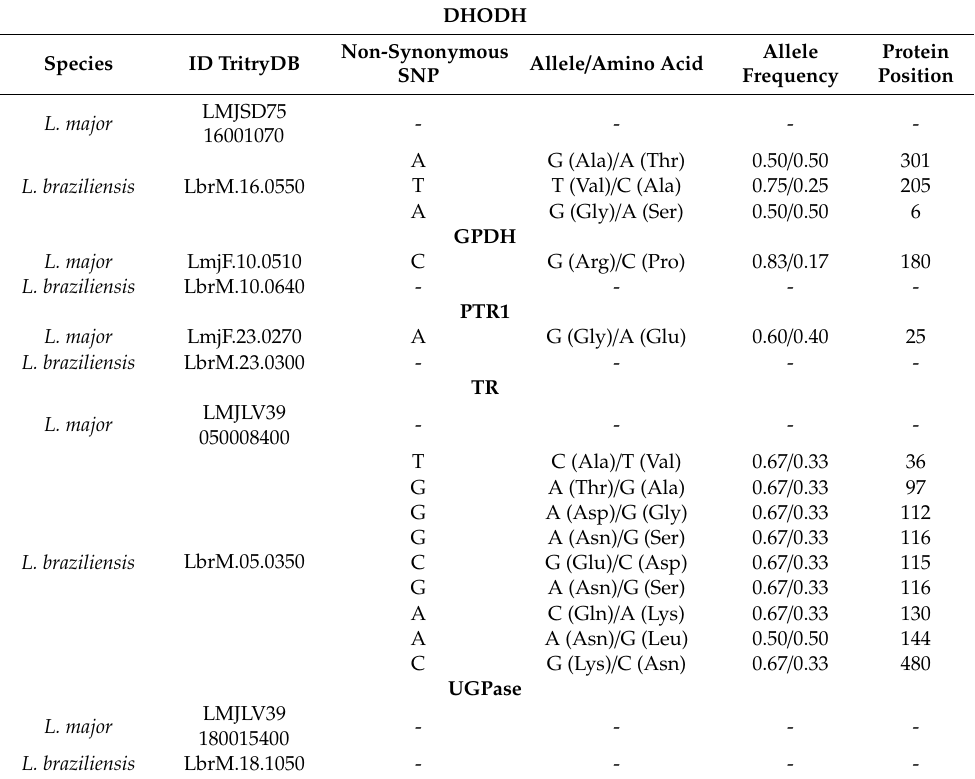
Table 11. Listofsinglenucleotidepolymorphisms(SNPs)identifiedintheTritryDBdatabase, withinformation regarding the ancestral allele, polymorphic allele, allelic frequency, and amino acid position for each species and enzyme studied. The SNPs with the highest allelic frequencies are highlighted in